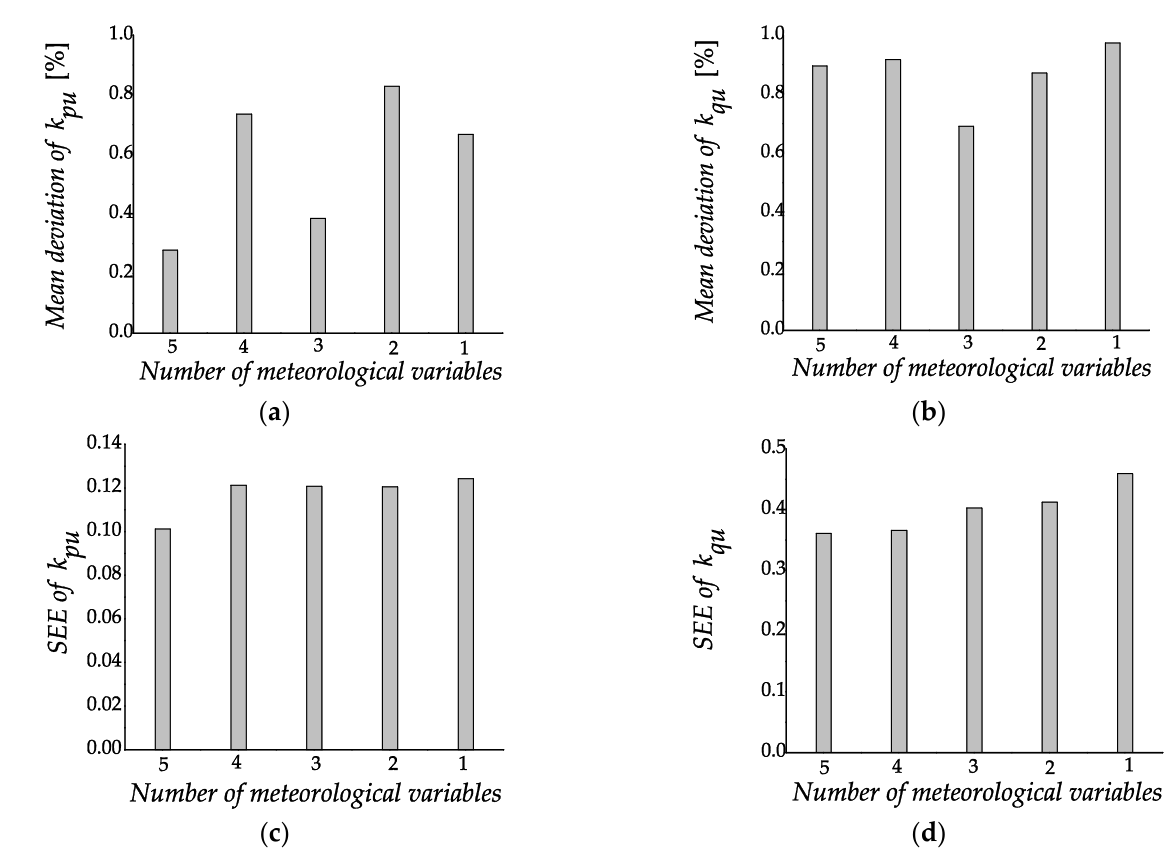
Figure 1. Mean values of deviations of ( a ) k pu , ( b ) k qu ; standard errors of estimate of ( c ) k pu , ( d ) k qu . Values are obtained when 5, 4, 3, 2 and 1 meteorological variable is used.